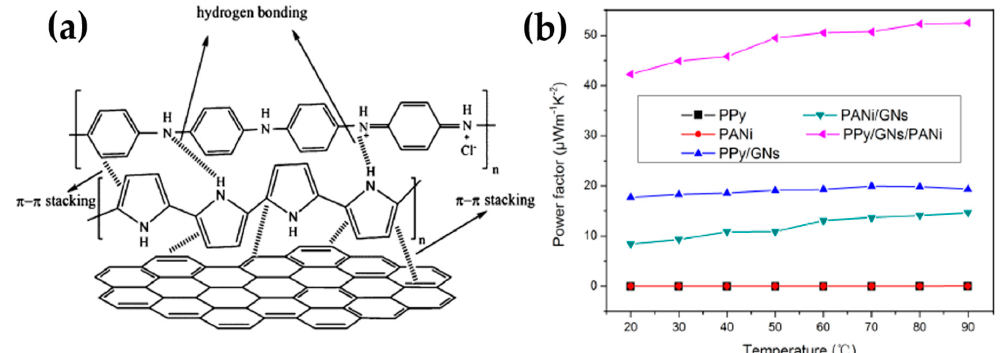
Figure 5. ( a ) The diagram of interactions of polypyrrole (PPy)/graphene nanosheets (GNs)/PANi composite and ( b ) Power factor of pure PPy, PANi, PPy/GNs composite, PANi/GNs composite, and PPy/GNs/PANi composite with 32 wt% graphene at different temperatures. Reprinted with permission from [50]. Copyright 2017 American Chemical Society.